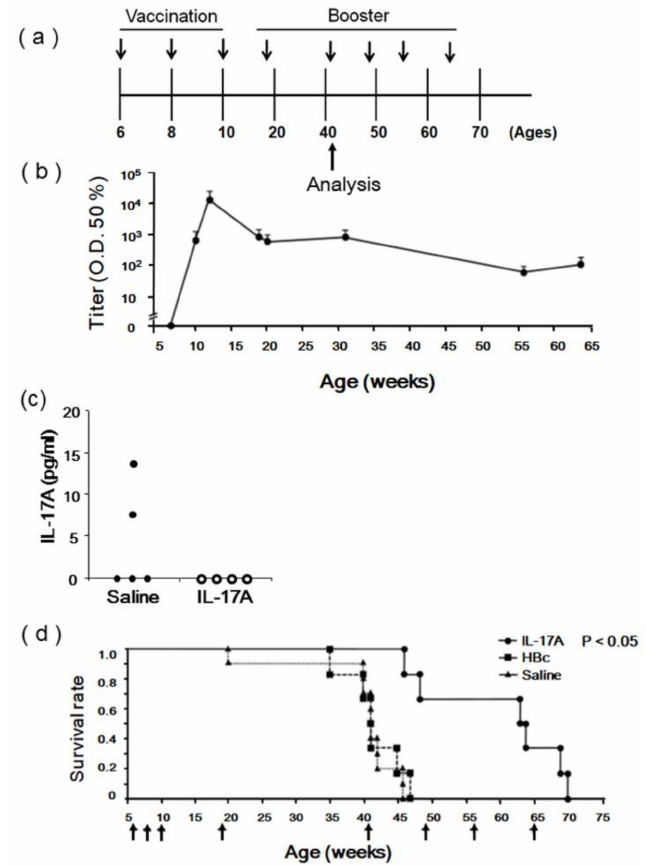
Figure 3. E ff ects of IL-17A DNA vaccine in NZBWF1 mice; ( a ) NZBWF1 mice were immunized with pcDNA3.1-HBc-IL17A1 (IL-17A1), pcDNA3.1-HBc (HBc), or saline via intramuscular administration